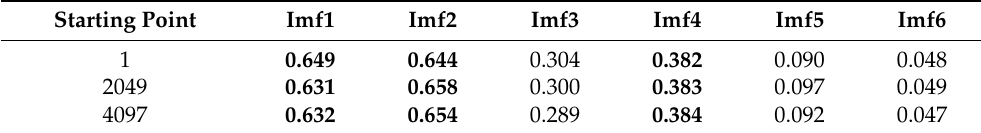
Table 7. The correlation coefficient of each mode of